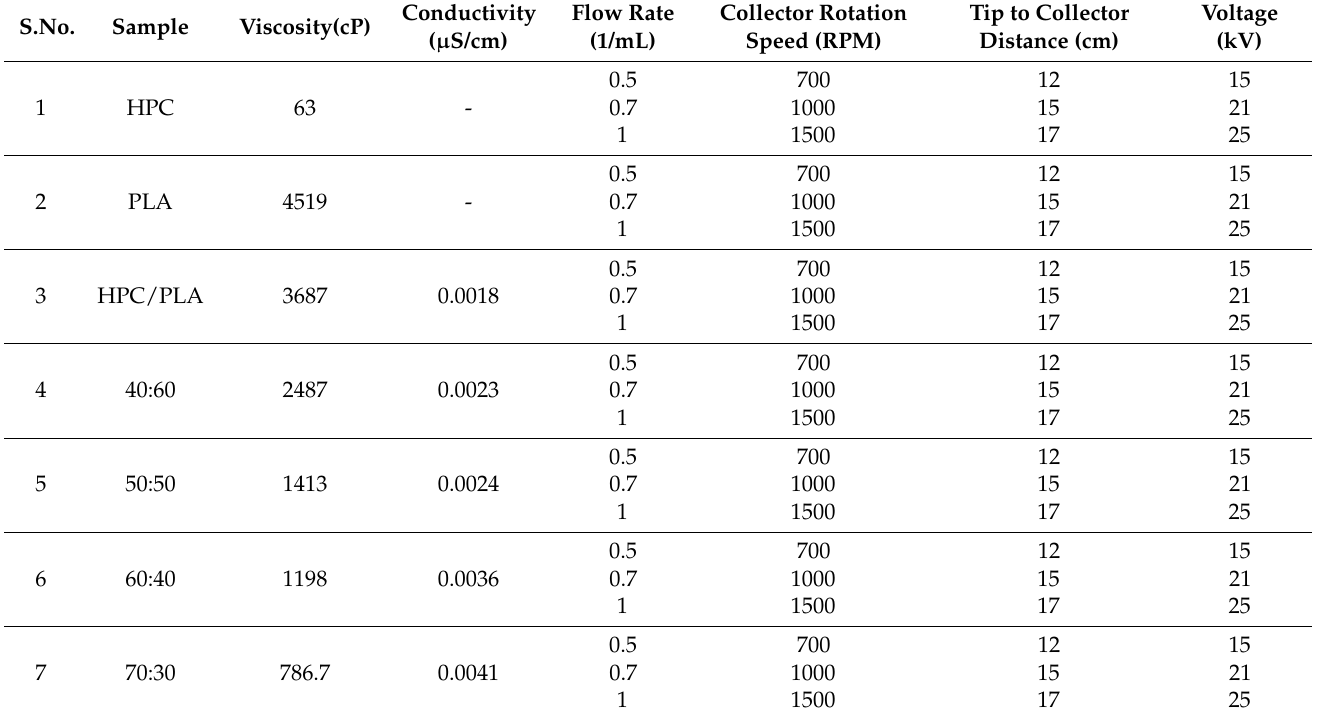
Table 2. Optimizing different parameters and its blending